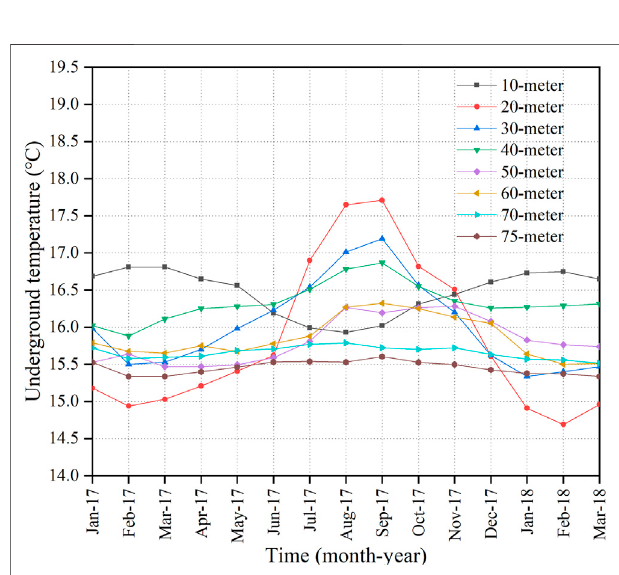
FIGURE 6 | Underground temperature at different depths from January 17, 2017 to March 18, 2018.